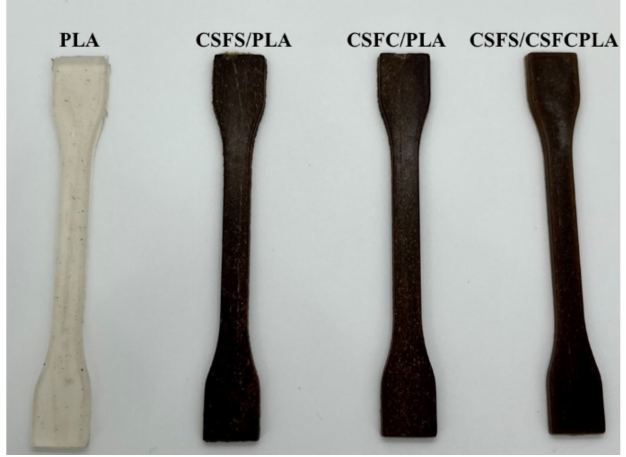
Figure 9. The appearance of different PLA